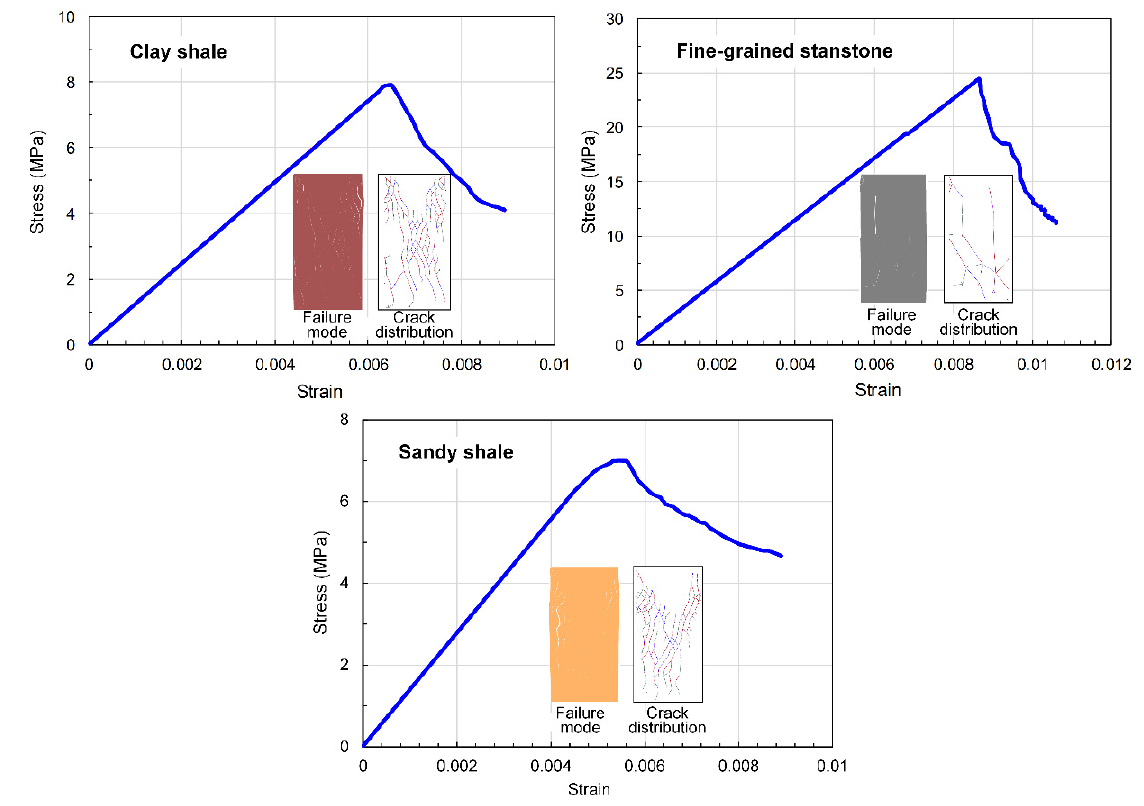
Figure 9. Simulated failure modes and stress-strain curves of rock mass